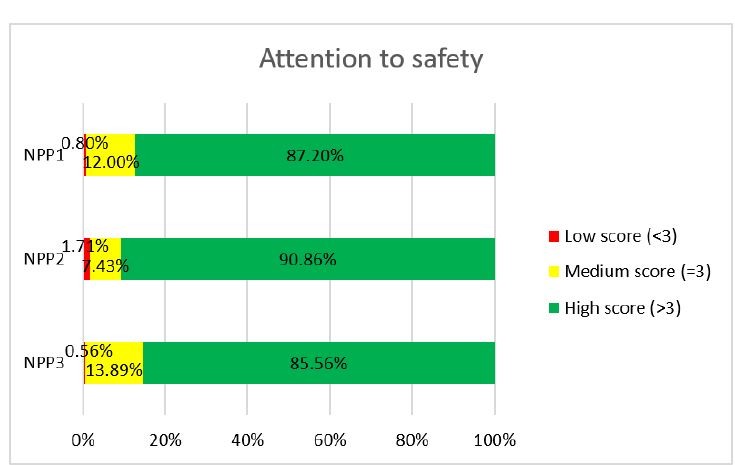
Figure 6. Categorized BARS percentages for attention to safety, by company.